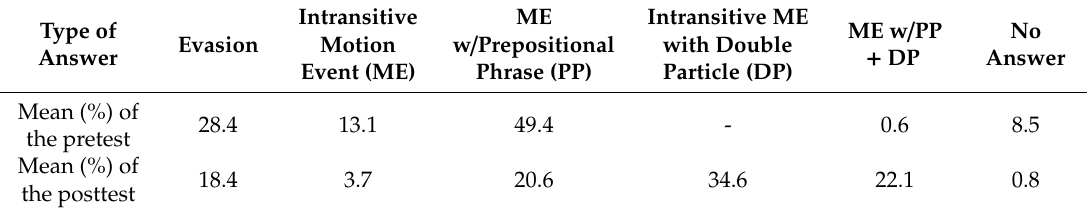
Table 2. Comparison of the types of answers in the production pretest and